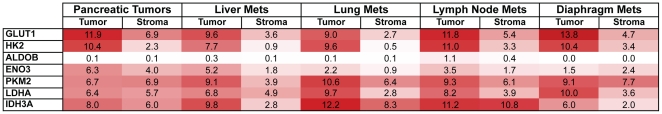
Differential protein expression levels by immunohistochemistry.Average tumor cell versus stromal cell expression intensities of GLUT1, HK2, ALDOB, ENO3, PKM2, LDHA and IDH3A in pancreatic tumor, and liver, lung, lymph node and diaphragm metastatic lesions are tabularized and indicated with gradations of red color.